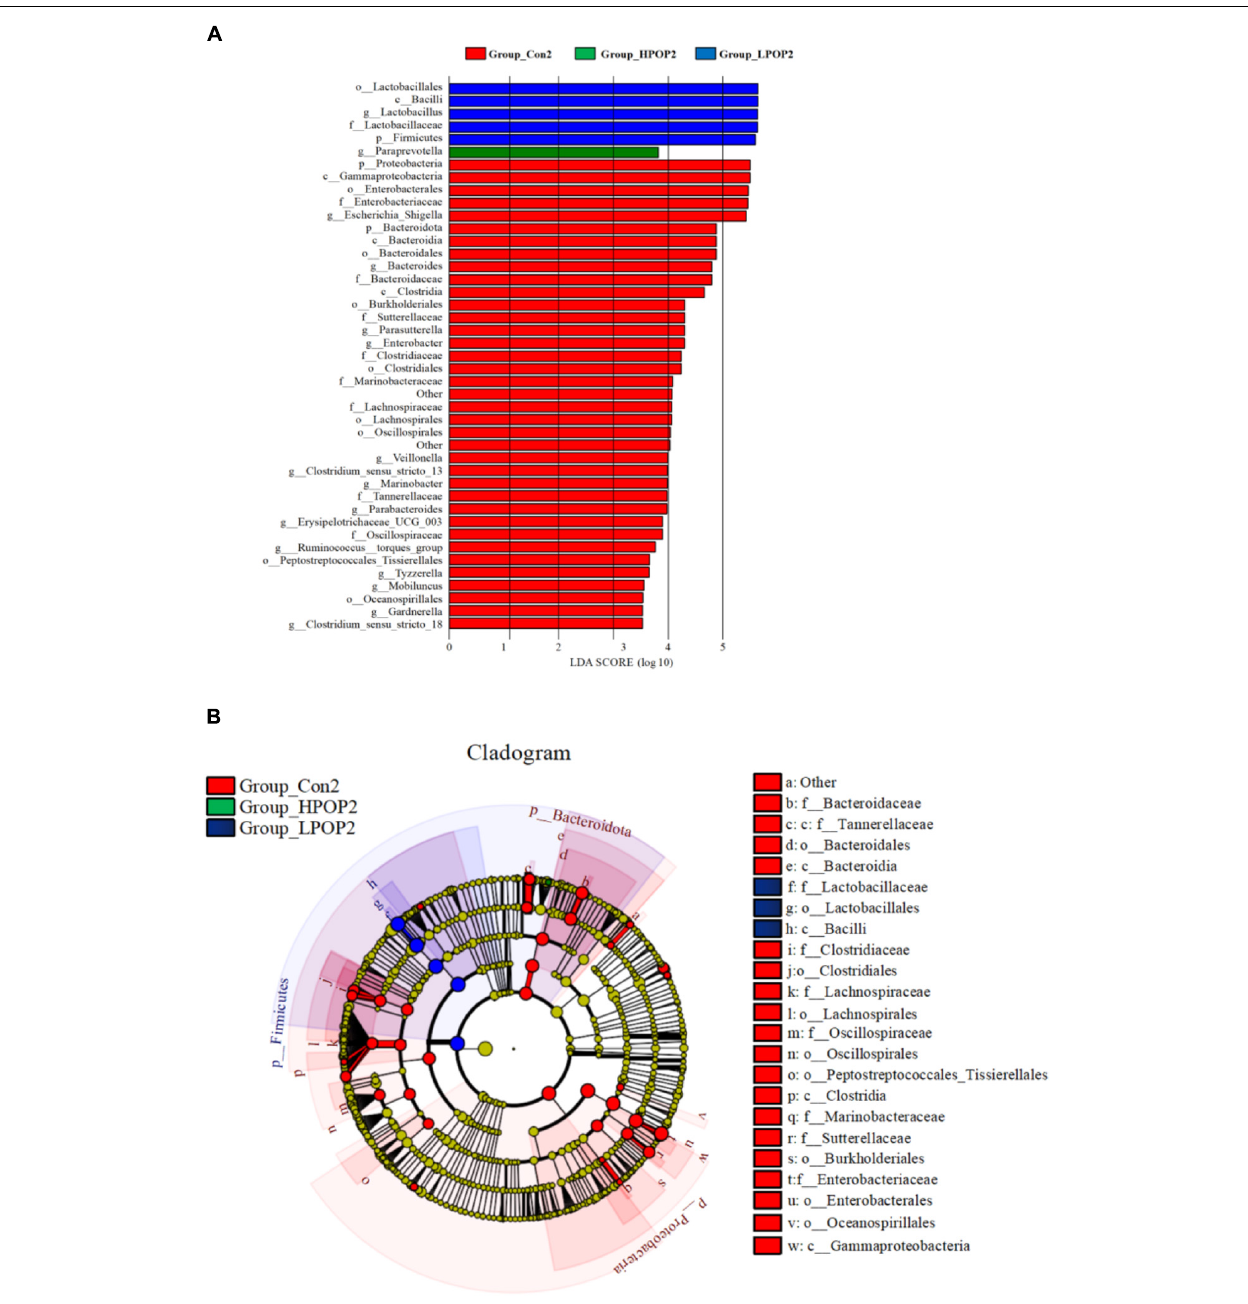
FIGURE 7 | LEfSe analysis showing the most differentially abundant taxa (LDA score > 3.0) after 48 h in vitro fecal fermentation with POP. (A) Histogram of the LDA scores. (B) Taxonomic cladogram of all differentially abundant taxa across all taxonomic levels [from the inner to outer rings, phylum (p), class (c), order (o), family (f), and genus